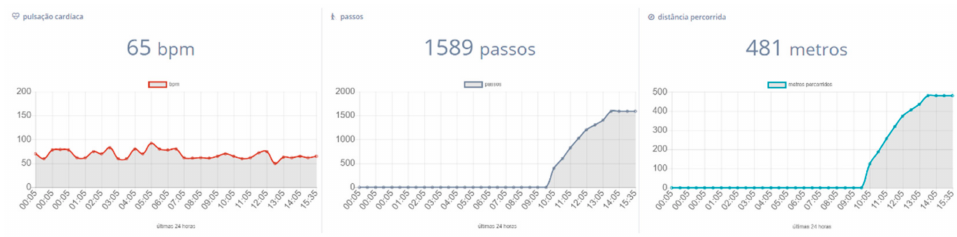
Figure 14. The elderly’s physical activity statistics.